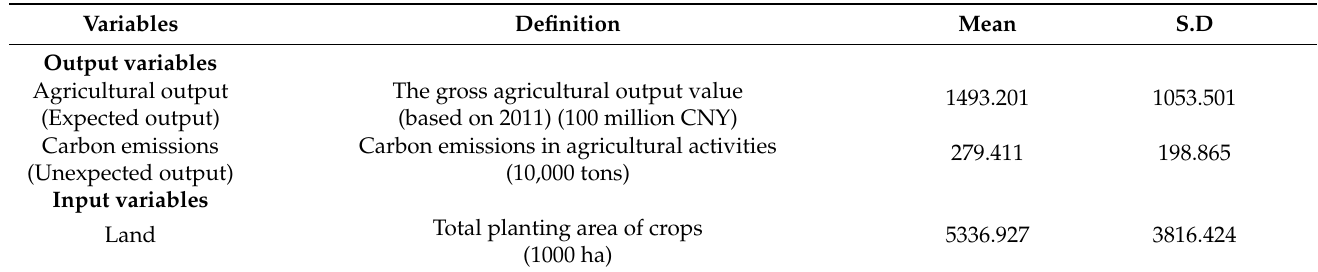
Table 2. Descriptive